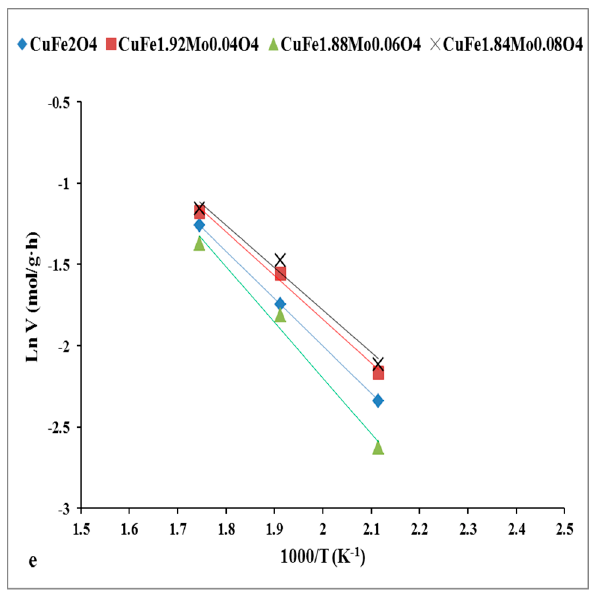
Figure 6. Catalytic performance of copper molybdenum ferrites in the oxidative coupling between methanol and ethanol as function of temperature (reaction conditions: molar ratio methanol:ethanol = 1; liquid fed 0.1 cm 3 / min; air flow 3000 cm 3 / min; catalyst amount 0.1 g), ( a ) CuFe 2 O 4 , ( b ) CuFe 1.92 Mo 0.04 O 4 , ( c ) CuFe 1.88 Mo 0.06 O 4 , ( d ) CuFe 1.84 Mo 0.08 O 4 , ( e ) Arrhenius plots for ethanol.